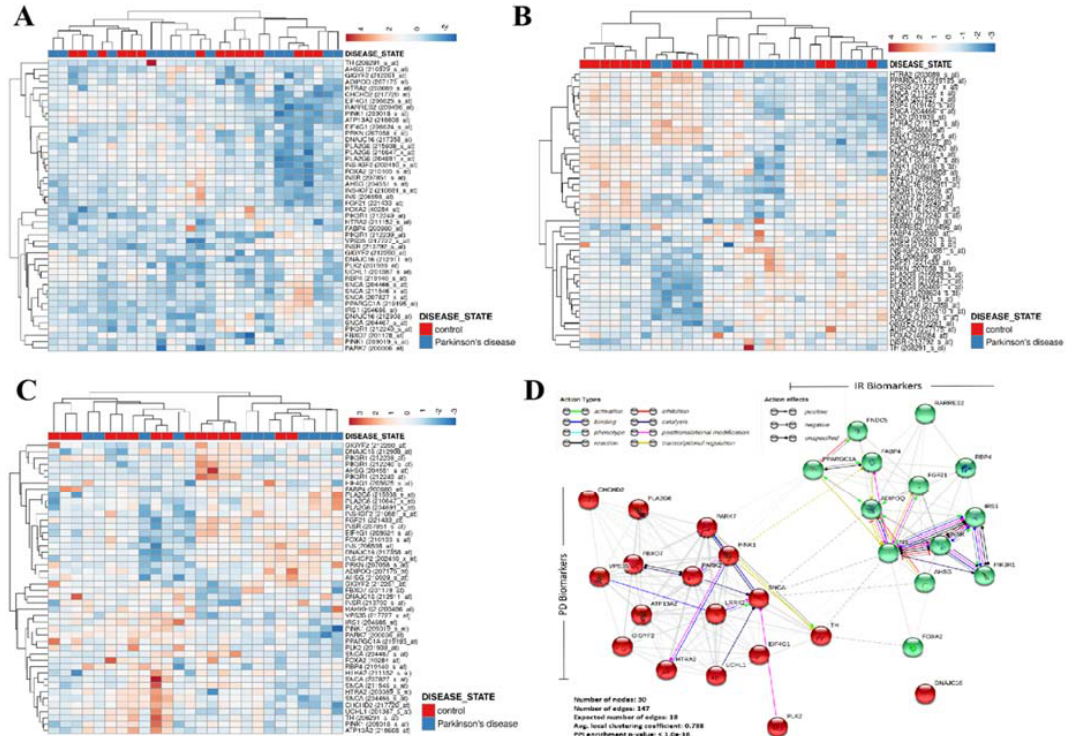
Figure 1. Patients’ genomic landscape indicates a nosological association between diabetes and Parkinson’s disease (PD), in silico. PD and insulin resistance (IR)-related transcript expression heatmaps from transcriptional analyses of ( A ) putamen (Homo sapiens, A-AFFY-33, AFFY_HG_U133A, E-GEOD-20291, 30 samples, 22,283 genes), ( B ) prefrontal area 9 (Homo sapiens, A-AFFY-33, AFFY_HG_U133A, E-GEOD-20168, 30 samples, 22,283 genes), and ( C ) whole substantia nigra (Homo sapiens, A-AFFY-33, AFFY_HG_U133A, E-GEOD-20292, 26 samples, 22,283 genes) in PD. Rows are centered; unit variance scaling is applied to rows. Both rows and columns are clustered using correlation distance and average linkage. ( D ) Visualization of the functional protein–protein interaction of PD and IR proteins as depicted by Search Tool for the Retrieval of Interacting Genes/Proteins database (STRINGdb).